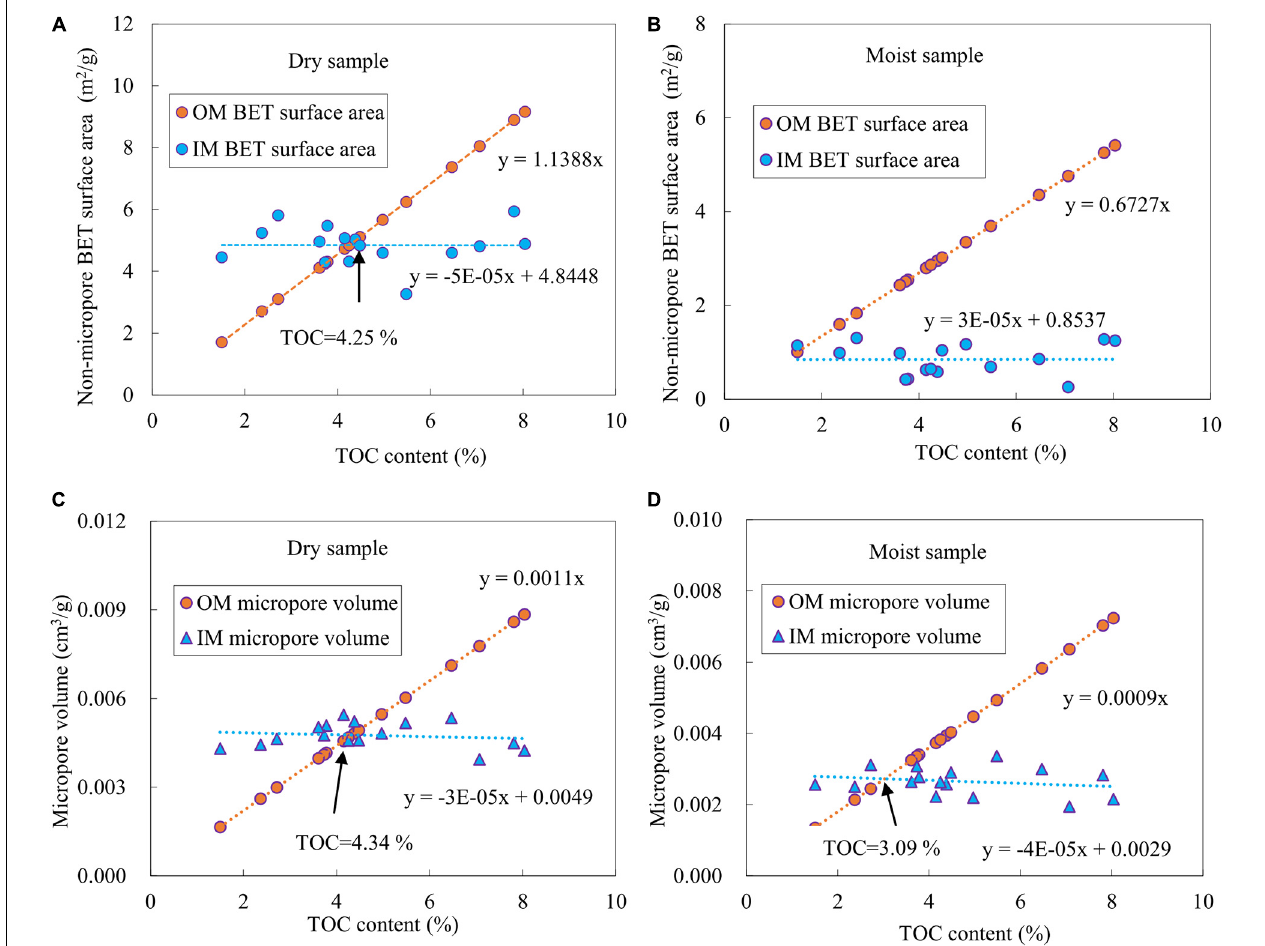
FIGURE 8 | The relationships of TOC with S BET − OM , S BET − IM (A,B) , and V mic − OM , V mic − IM (C,D) for the dry and moist samples. See details in text.